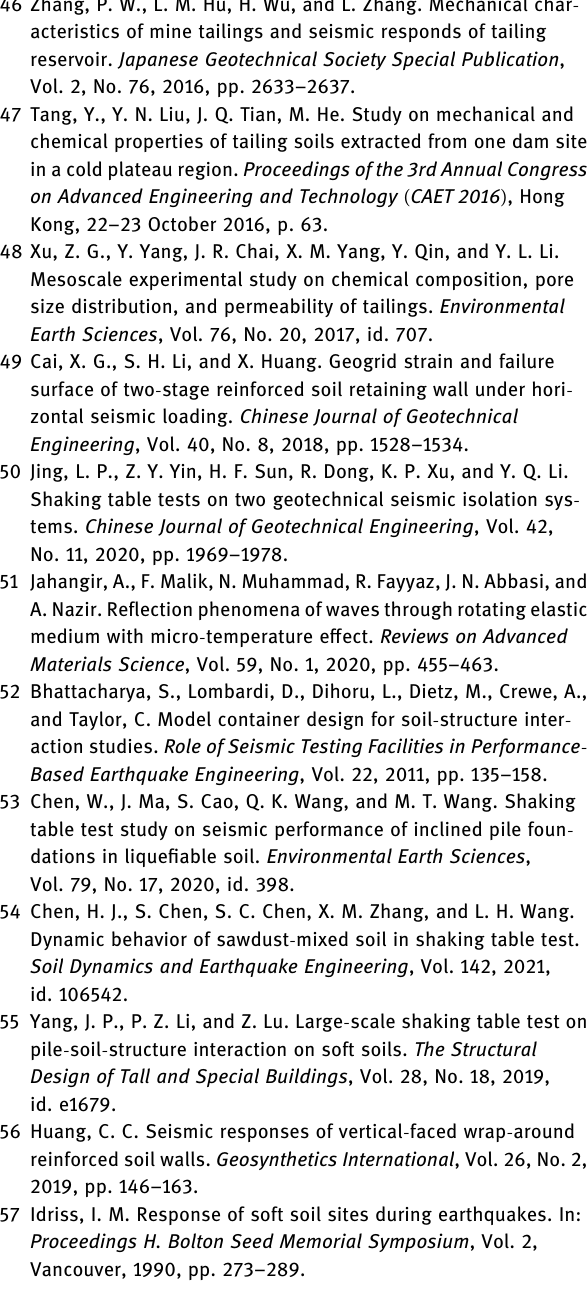
table test study on seismic performance of inclined pile foun